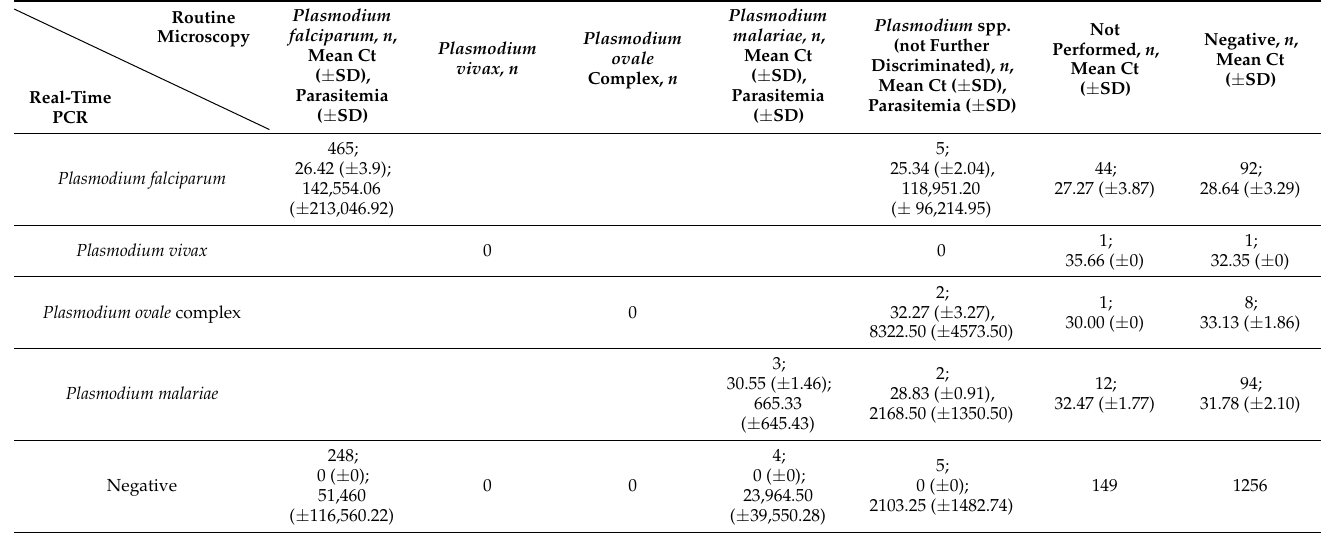
Table A3. Distribution of Plasmodium species by routine microscopy or PCR-based detection in the incubated blood culture materials ( n =